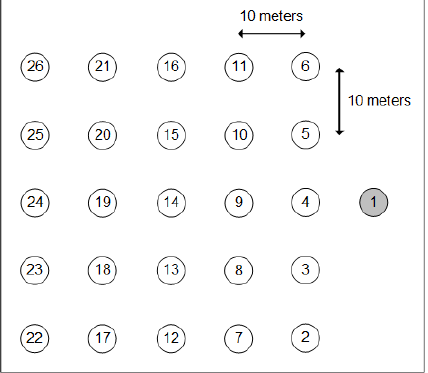
Figure 22. The 5 × 5 m grid